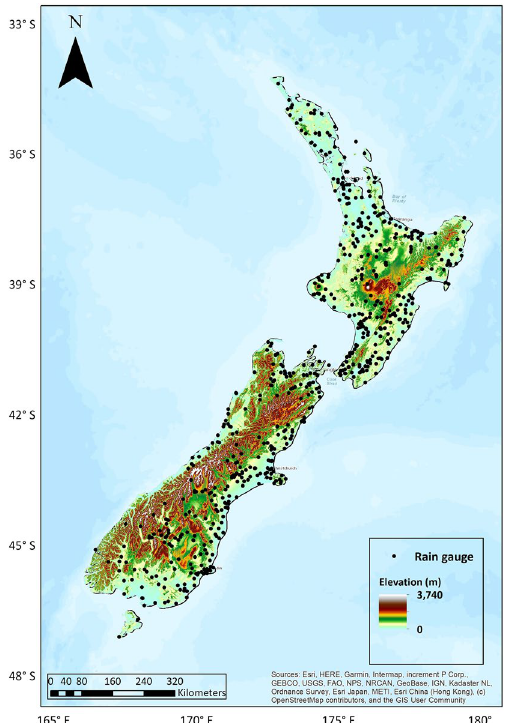
Figure 5. A map of New Zealand showing the location of 654 rain gauges.